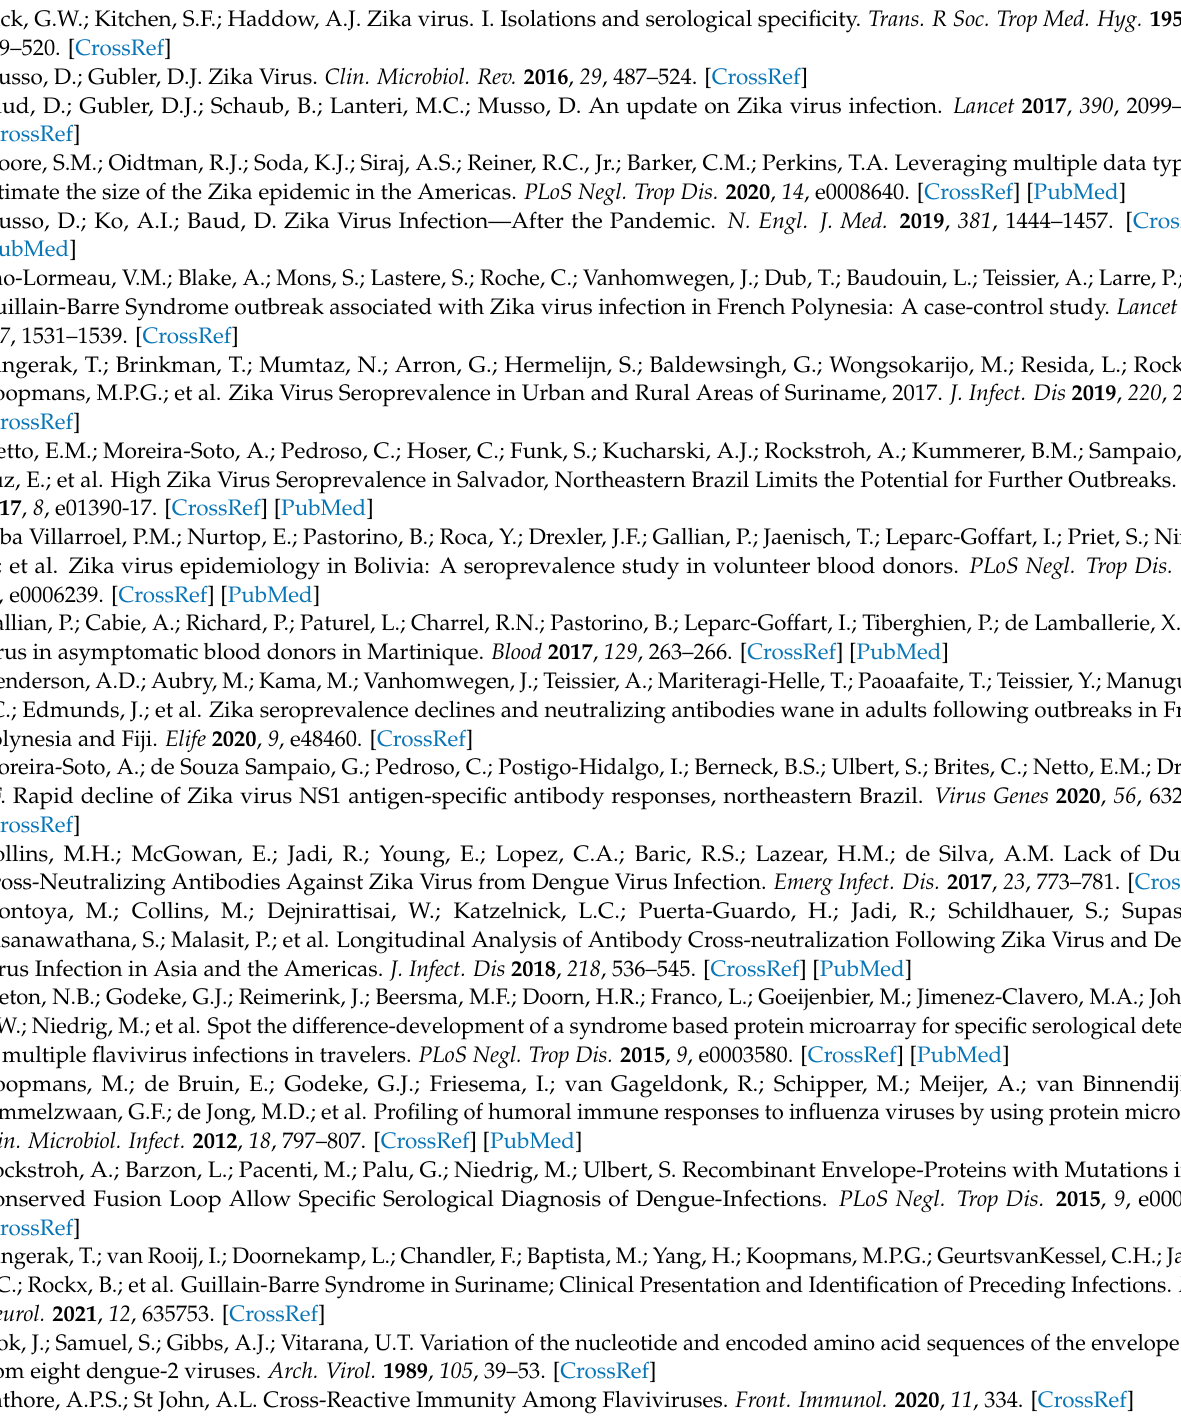
compared to titers from other serological assays. A : Correlation between ZIKV NS1 PMA IgG titers and titers from the ZIKV VNT. The dotted line indicates the cut-off value for a positive ZIKV VNT test result. B : Correlation between ZIKV NS1 PMA IgG titers and titers from the DENV-2 VNT. The dotted line indicates the cut-off value for a positive DENV-2 VNT test result. C : Correlation between ZIKV NS1 PMA IgG titers and ratios from the ZIKV NS1 IgG ELISA. The dotted line indicates the cut-off value for a positive ZIKV NS1 IgG ELISA test